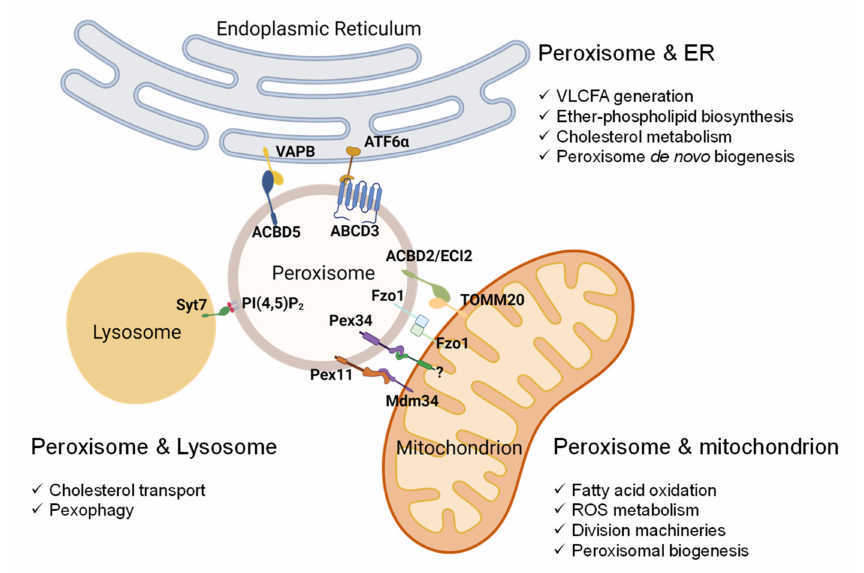
Figure 2. Peroxisome-organelle membrane contact sites and their roles in organelle functions. Per- oxisomes’ contact with mitochondria involves (1) peroxisomal Pex11 and mitochondrial Mdm34, (2) peroxisomal Pex34 and an unknown mitochondrial protein, (3) mitofusin Fzo1 on both peroxisome and mitochondria, and (4) peroxisomal ACBD2/ECI2 and mitochondrial TOMM20. The interaction between peroxisomes and the ER involves (1) peroxisomal ACBD5 and resident ER protein VAPB and (2) peroxisomal ABCD3 and ER protein ATF6 α upon Ceapin treatment. In mammalian cells, the con- tact between peroxisomes and lysosomes involves phospholipid PI(4,5)P 2 on the peroxisomal mem- brane and lysosomal Syt7. Abbreviations: Pex11, peroxin 11; Mdm34, mitochondrial distribution and morphology protein 34; Pex34, peroxin 34; Fzo1, mitofusin; ACBD2/ECI2, acyl-coenzyme A-binding domain or enoyl-CoA- δ isomerase 2; TOMM20, translocase of outer mitochondrial membrane 20; ACBD5, acyl-CoA binding domain-containing protein 5; VAPB, vesicle-associated membrane protein- associated protein B/C; ABCD3, ATP binding cassette subfamily D member 3; ATF6, activating transcription factor 6; PI(4,5)P 2 , phosphatidylinositol 4,5-bisphosphate; Syt7, synaptotagmin